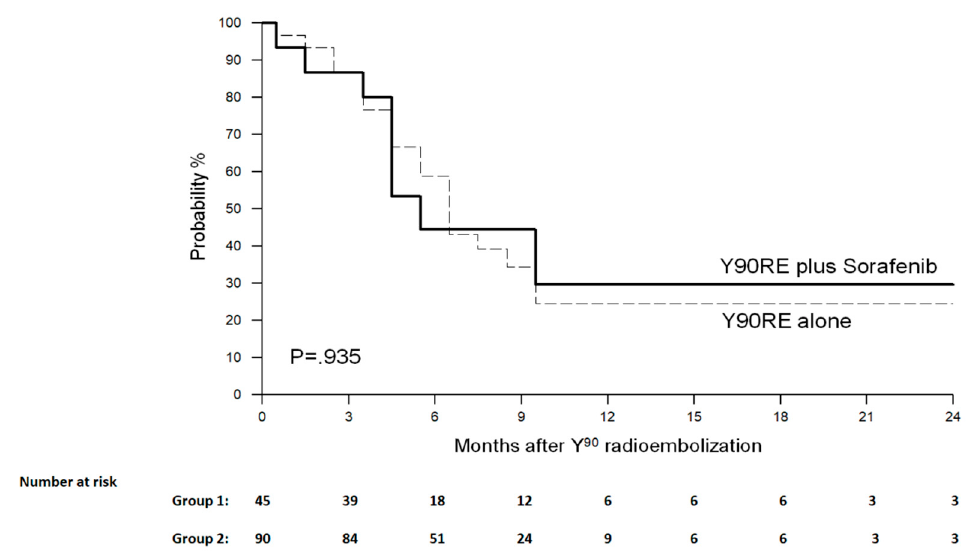
Figure 3. Progression-free survival curves. Median progression-free survival was 6 months and 7 months in the two groups, respectively ( p = 0.992).